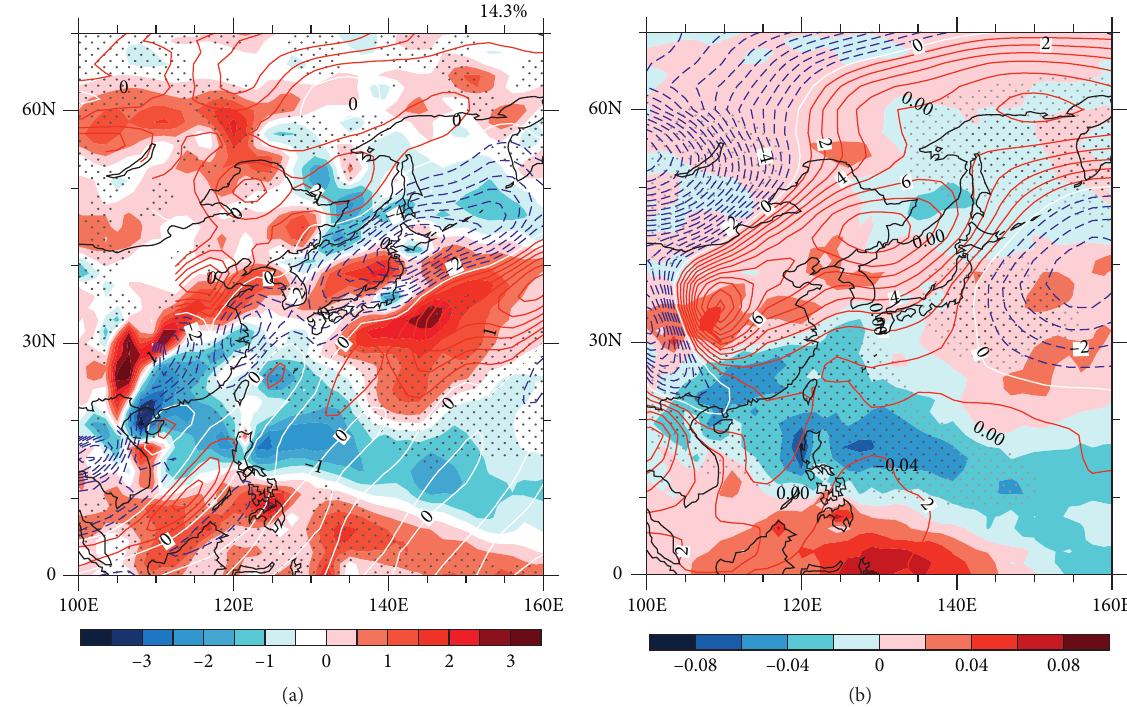
Figure 10: (a) Pacific-Japan (PJ) teleconnection patterns in JA from 1979 to 2017 (shadings) (b) JA precipitation (shadings, units: m · day − 1 ) regressed on the corresponding PJ index. Red and blue contour lines indicate positive and negative anomalies of (a) 850hPa relative vorticity (units: 10 − 6 s − 1 ) and (b) 500 hPa height (units: gpm) generated by COM experiment on day 15. Dark (light) stippling indicates values significantly exceeding the 99% (90%) confidence level using Student’s t test; the variance fraction explained by EOF1 is denoted at the top- right corner in (a).